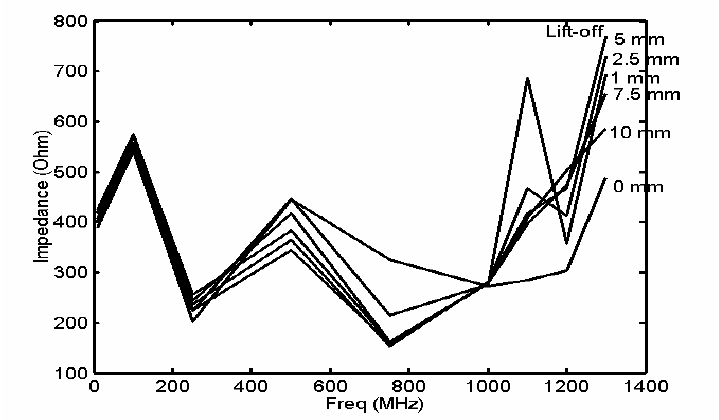
Figure 31. The impedance magnitude as a function of frequency for milk with different